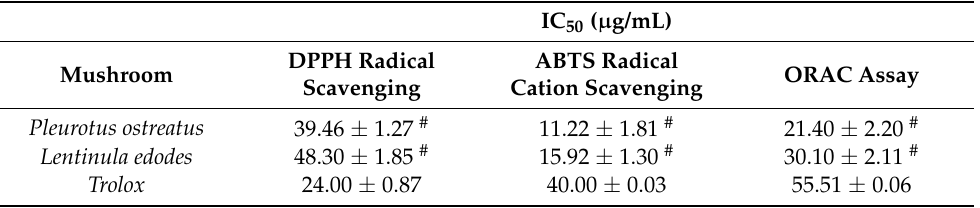
Table 6. IC50 values of Pleurotus ostreatus and Lentinula edodes in the radical scavenging, ABTS radical cation scavenging and ORAC assays.